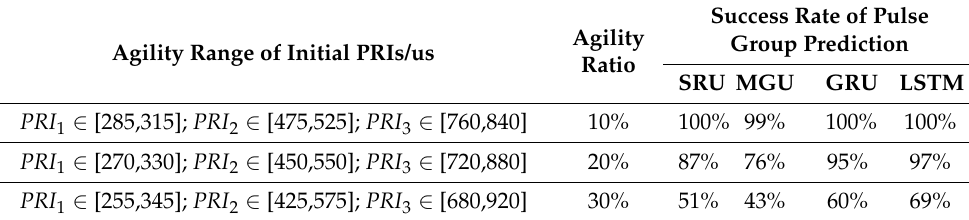
Table 2. Influence of PRI agility range on PRI feature